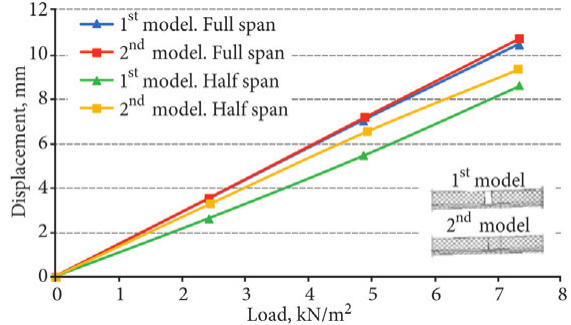
Fig. 7. Horizontal support reaction of stabilization cable depending on loading